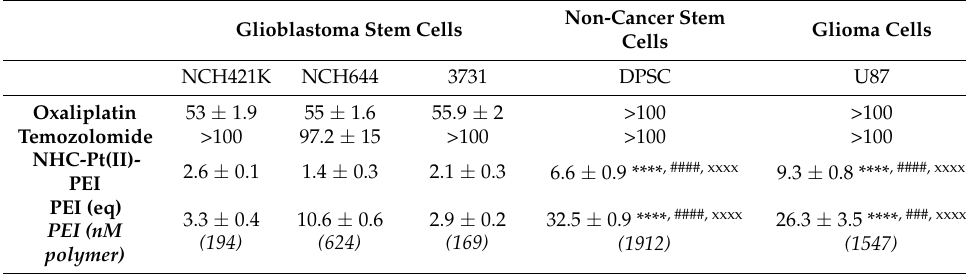
Table 1. IC 50 values ( µ M) of the compounds after 24 h of treatment.